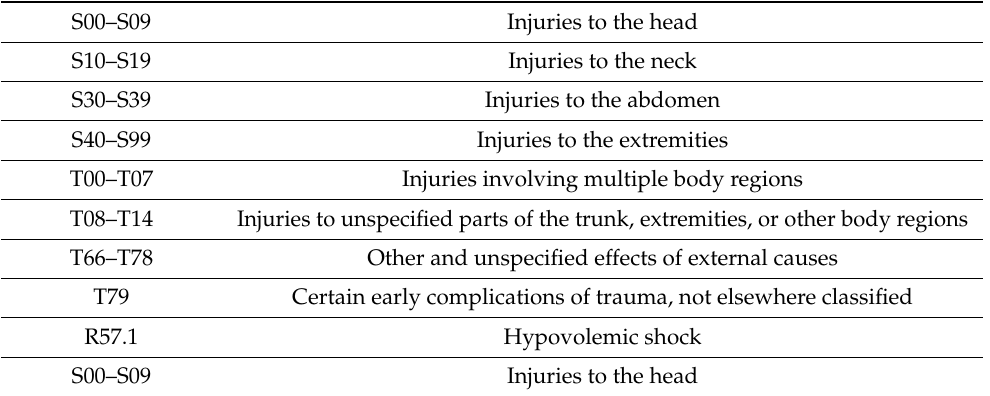
Table 2. Comorbidities/extra-thoracic injuries (ICD-10-GM).